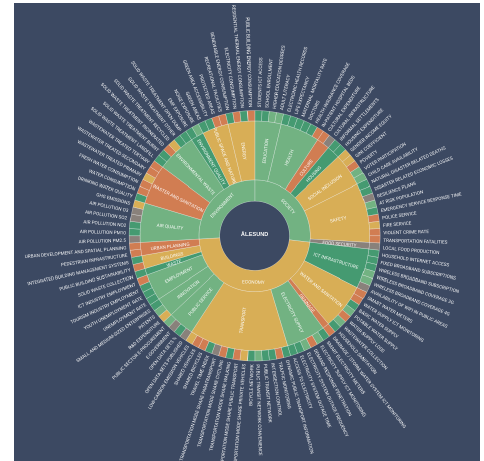
Figure 4. Map-based browsing tool to support the assessment of indicators related to the Sustainable Development Goals of different cities across Norway.